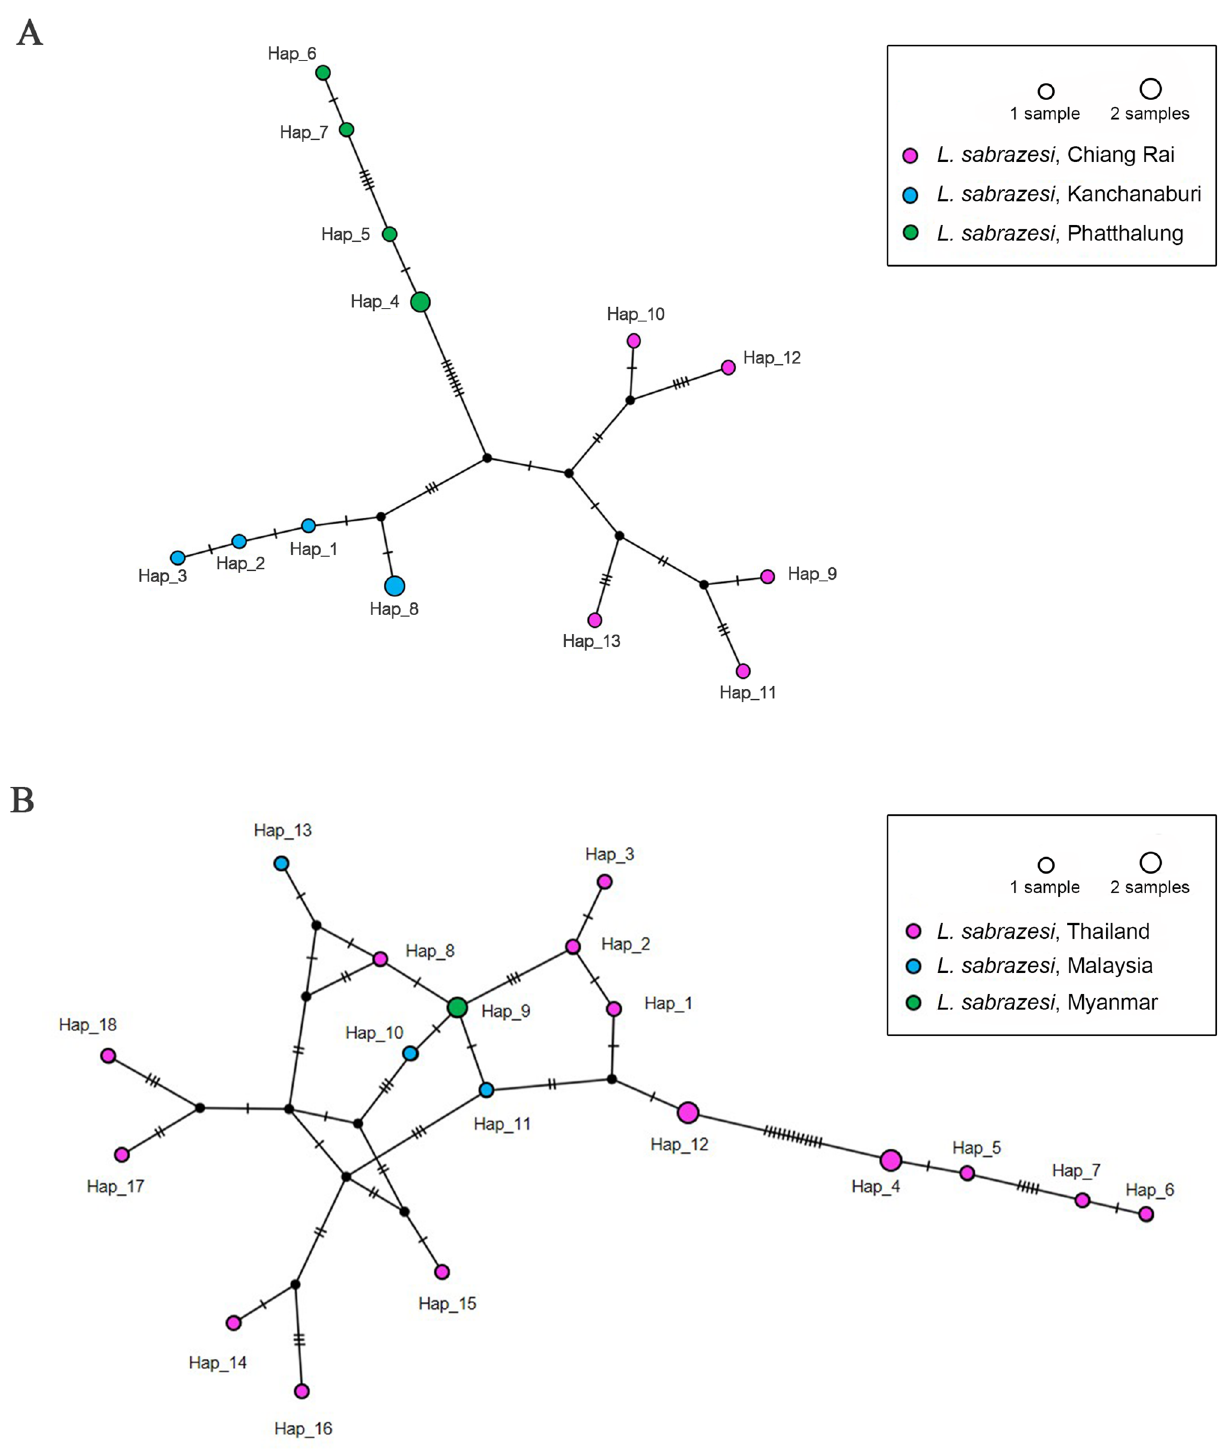
Figure 3. TCS network of haplotypes based on the L. sabrazesi cytb gene sequences detected in Thailand ( A ) and other countries ( B